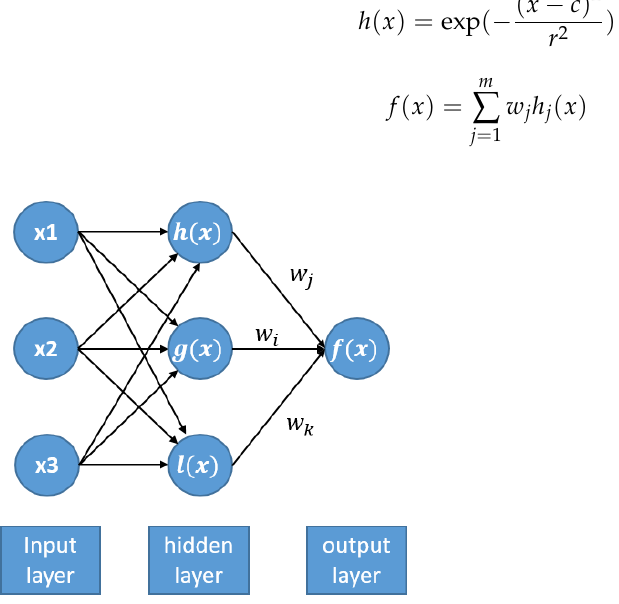
Figure 3. Schematic diagram of the radial basis function network.